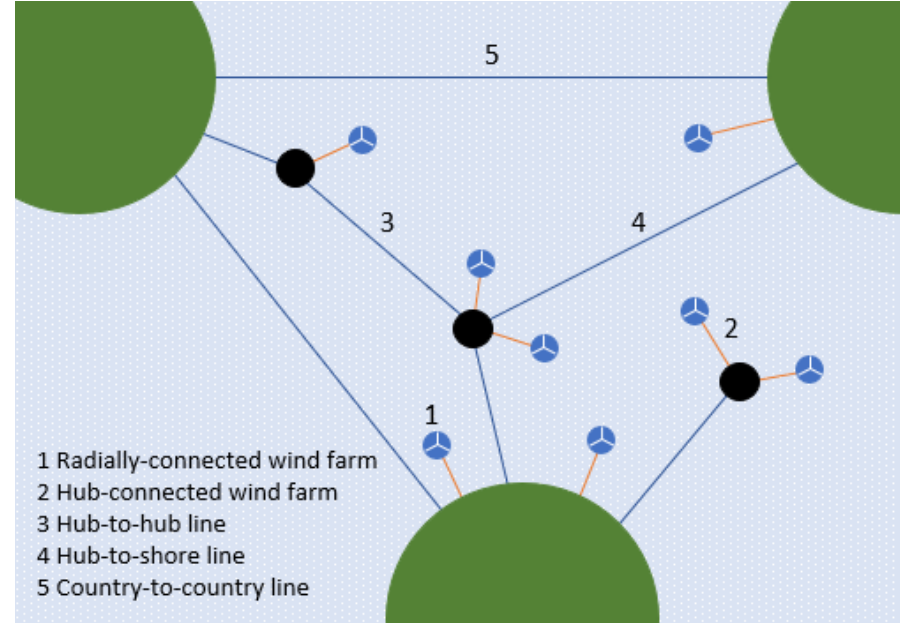
Figure 1. Possible configurations of offshore